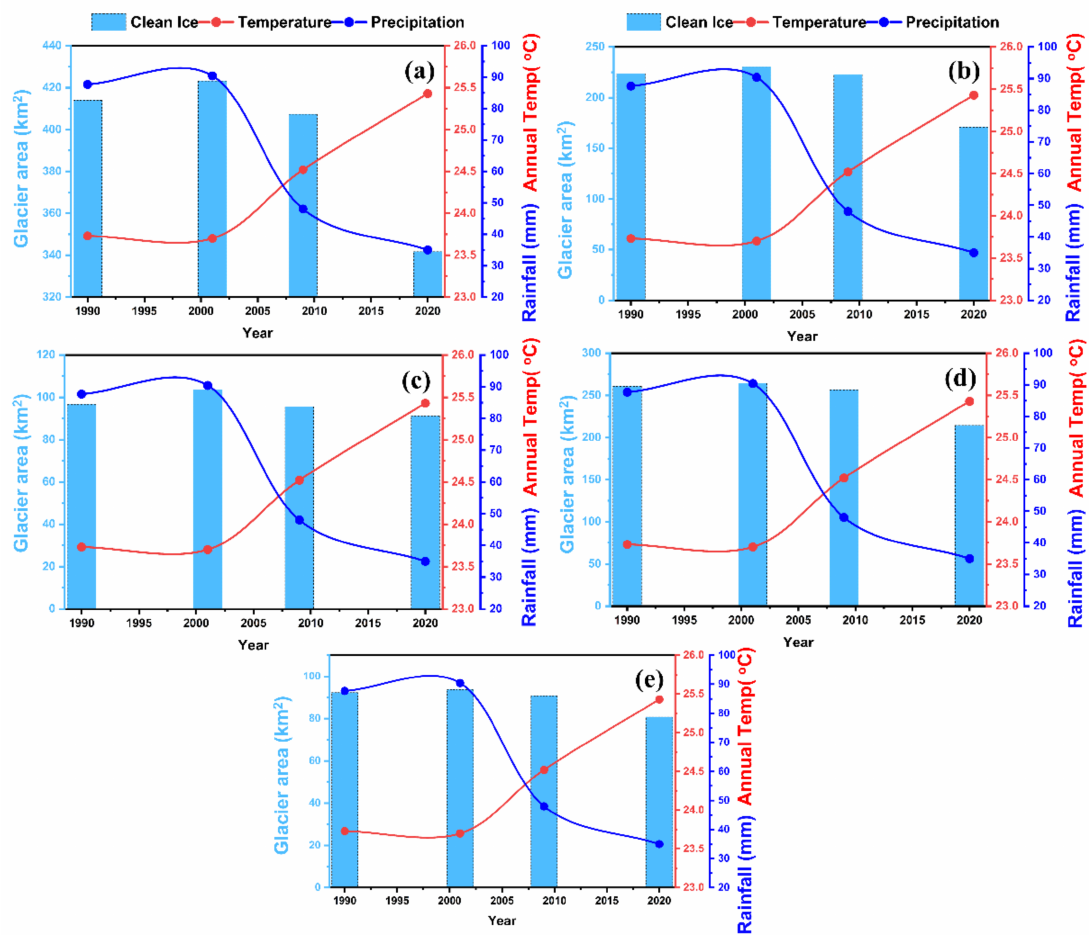
Figure 11. Correlation of glacier area with temperature and precipitation; ( a ) Biafo, ( b ) Hispar, ( c ) Khurdopin, ( d ), Panmah, ( e ) Virjerab. The vertical axis on the left-hand side show glacier area (km 2 ) while the right-hand side of the graph shows temperature ( ◦ C) and precipitation (mm).